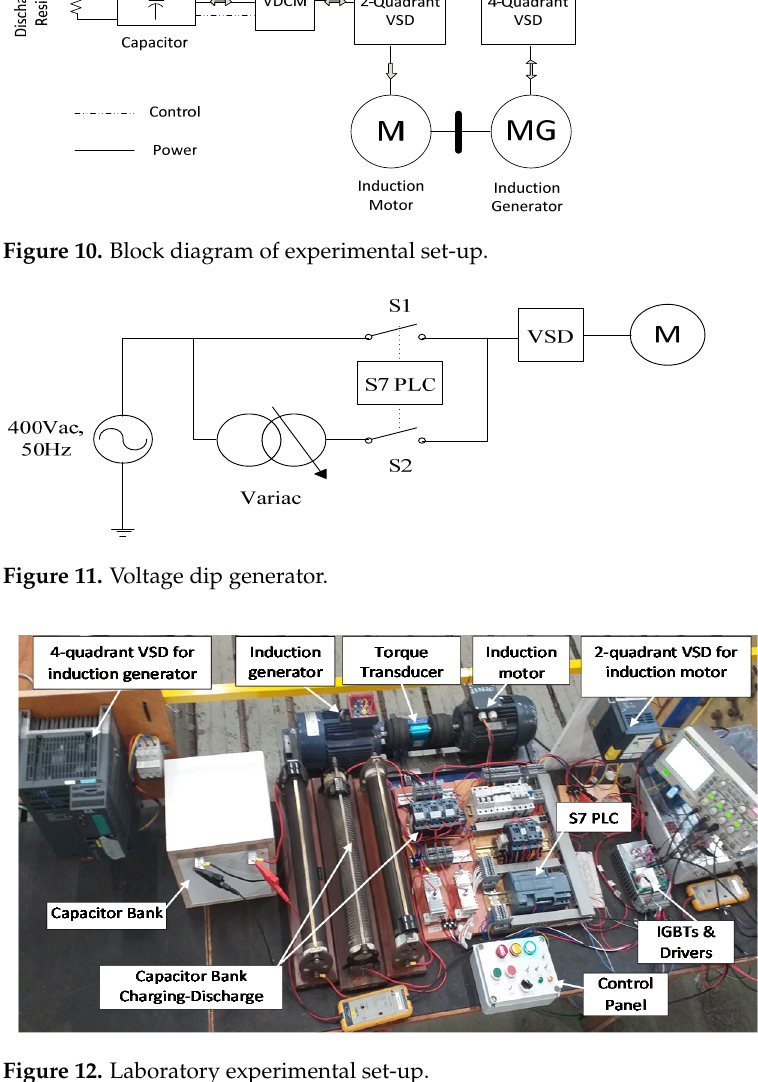
Figure 10. Block diagram of experimental set-up.